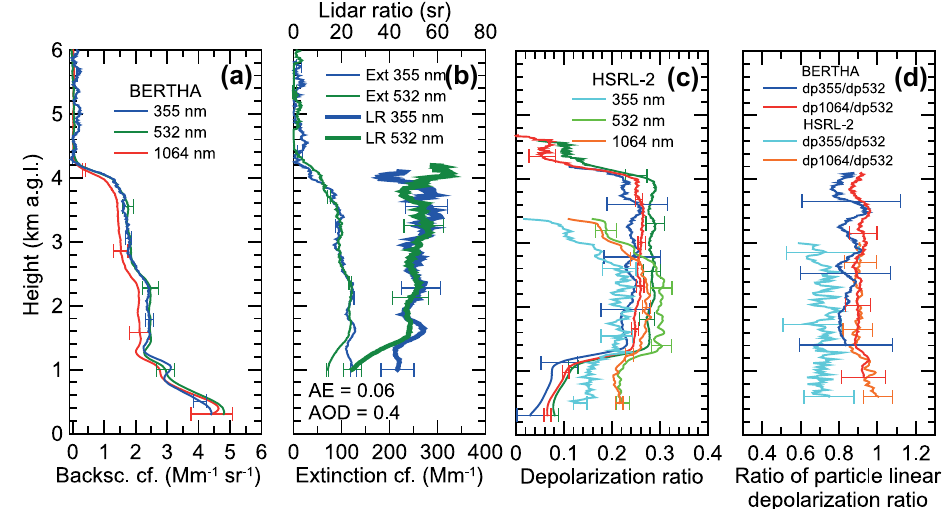
Figure 12. Same as Fig. 9, except for 6–7 July 2014, 23:18–01:33UTC. For comparison, respective height profiles of the particle linear depolarization ratio (355nm in light blue, 532nm in light green, and 1064nm in orange) and for the ratio of depolarization ratios (in light blue and orange) measured with an airborne triple-wavelength polarization lidar (HSRL-2) (Burton et al., 2015) on 13 July 2014, 17:00UTC are shown. The airborne lidar observations were performed in Missouri (midwestern United States), about 7000km and 7 days downwind of Barbados.